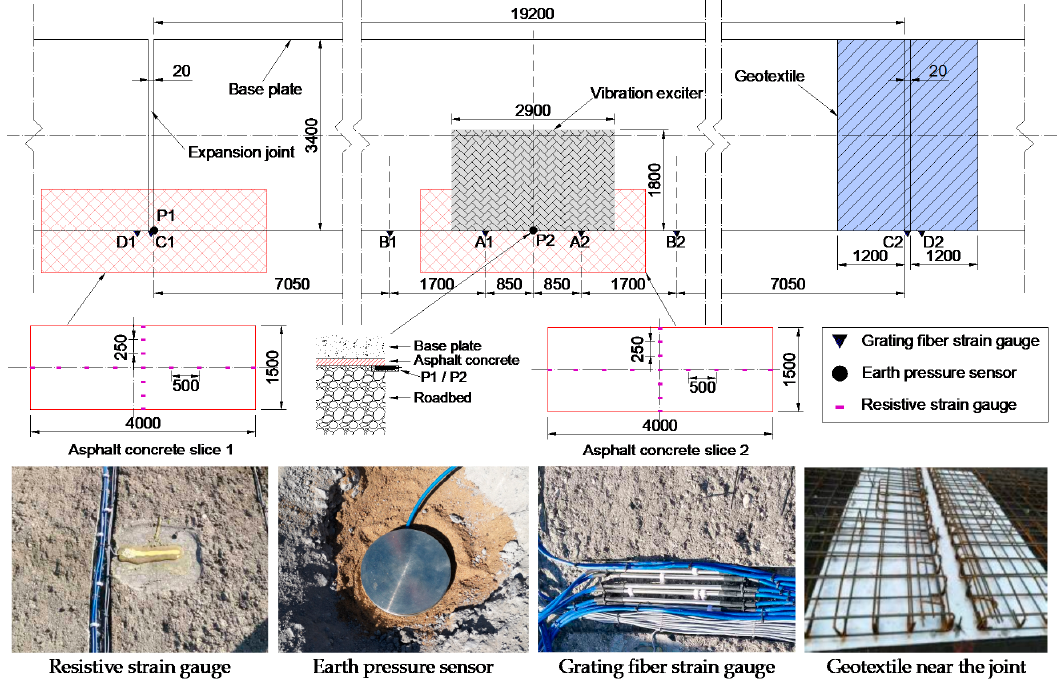
Figure 6. Arrangement of sensors in the test (unit: mm).